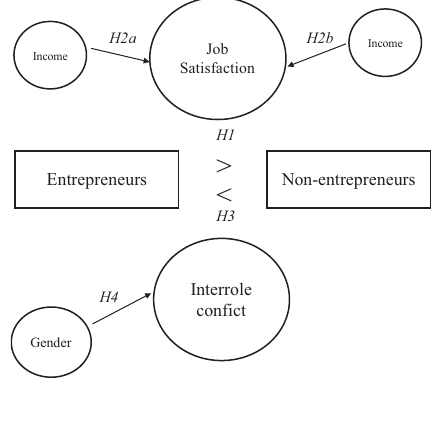
Figure 1. Conceptual